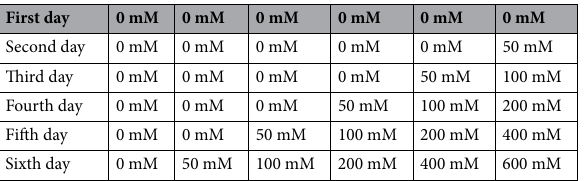
Table 1. The NaCl pretreatment regime of irrigation used in the halophyte seedling